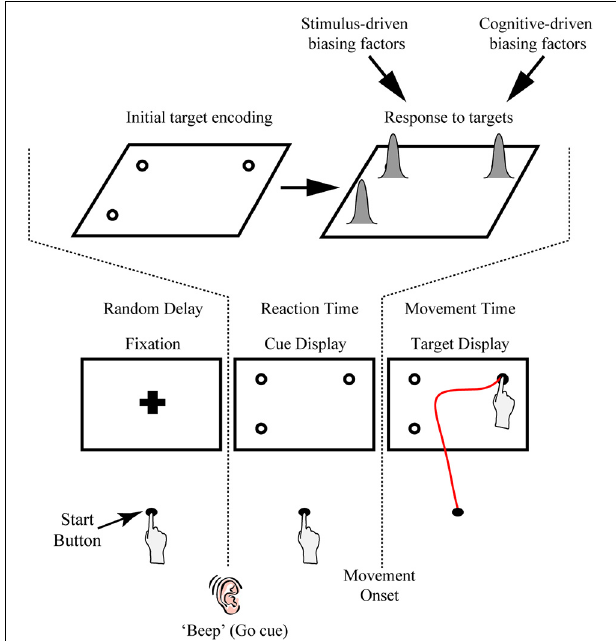
FIGURE 6 | Proposed descriptive model explaining initial reach trajectory biases. Bottom: General timing of the rapid reach task, illustrated from a view behind the participant’s hand. Red trace in the right panel denotes an exemplar trajectory toward the target display on trials in which the right target was cued. Top: Proposed temporal evolution of neural responses to the cue display prior to movement. Gaussian distributions (in gray) represent “hills” of activity that bias early reach trajectory responses. These “attentional landscapes” and associated “relevance maps” likely have a myriad of inputs, including stimulus-driven and cognitively-driven biasing factors, which can be assessed through the careful analysis of reach trajectories described